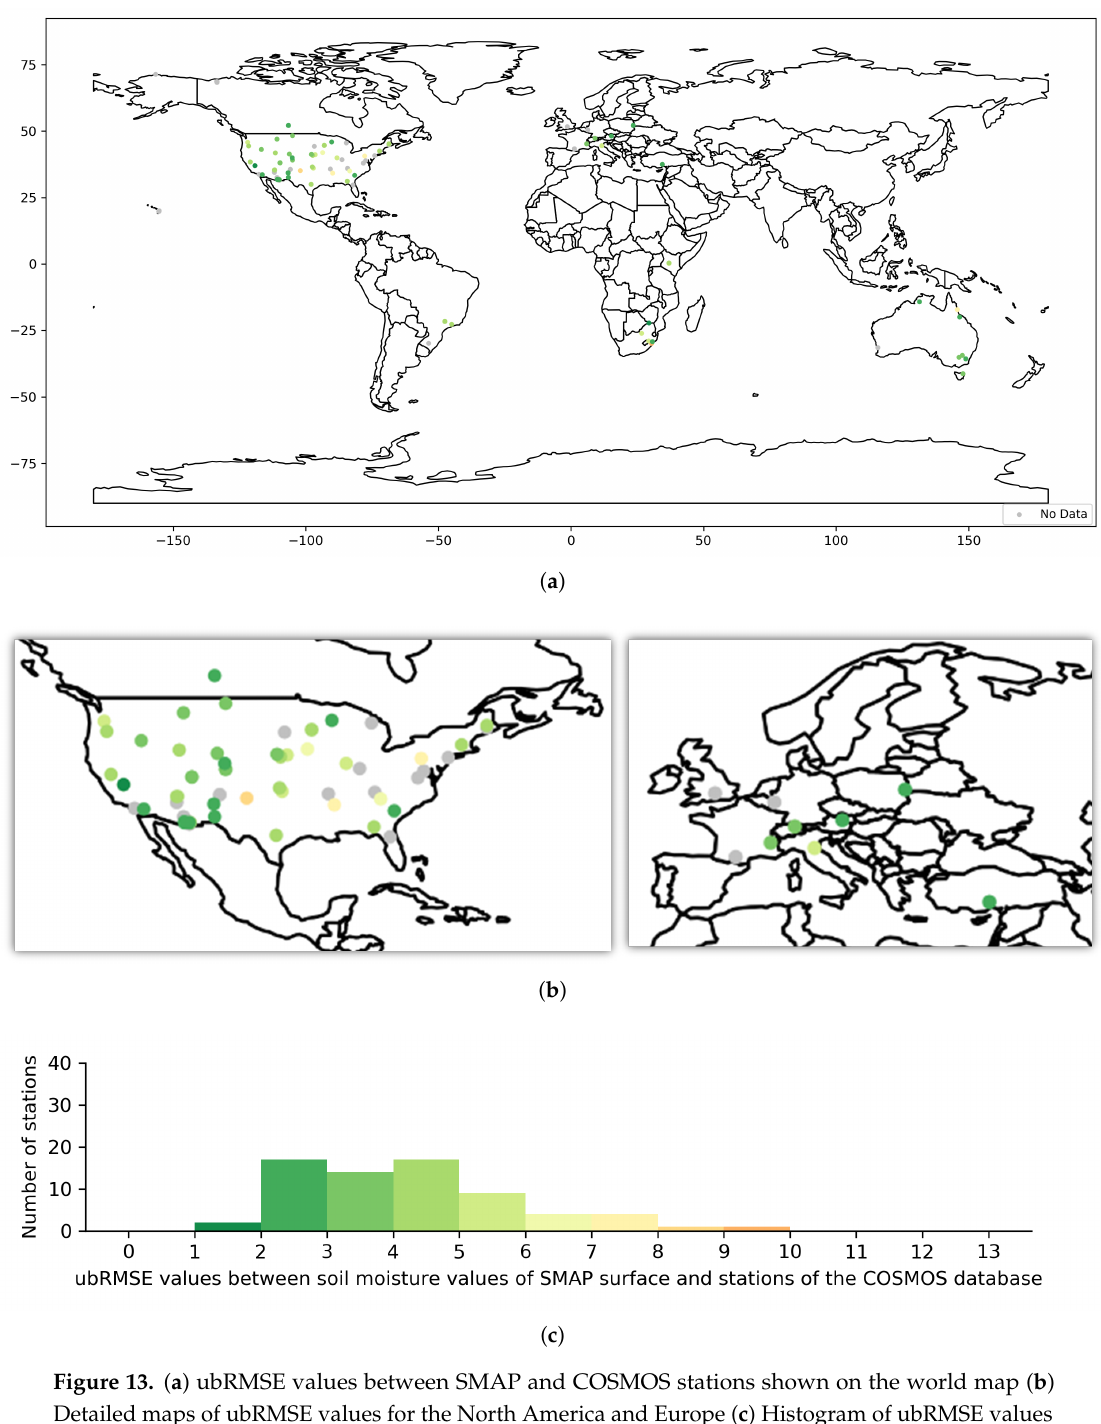
Figure 13. ( a ) ubRMSE values between SMAP and COSMOS stations shown on the world map ( b ) Detailed maps of ubRMSE values for the North America and Europe ( c ) Histogram of ubRMSE values between SMAP and COSMOS